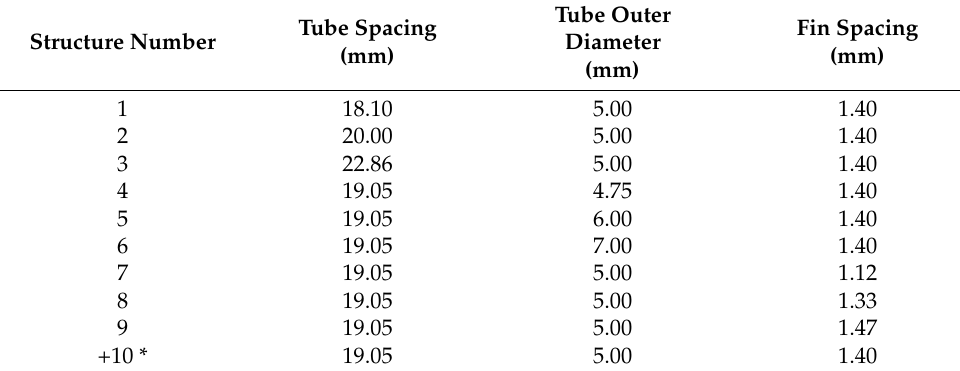
Table 8. Structural parameters of different